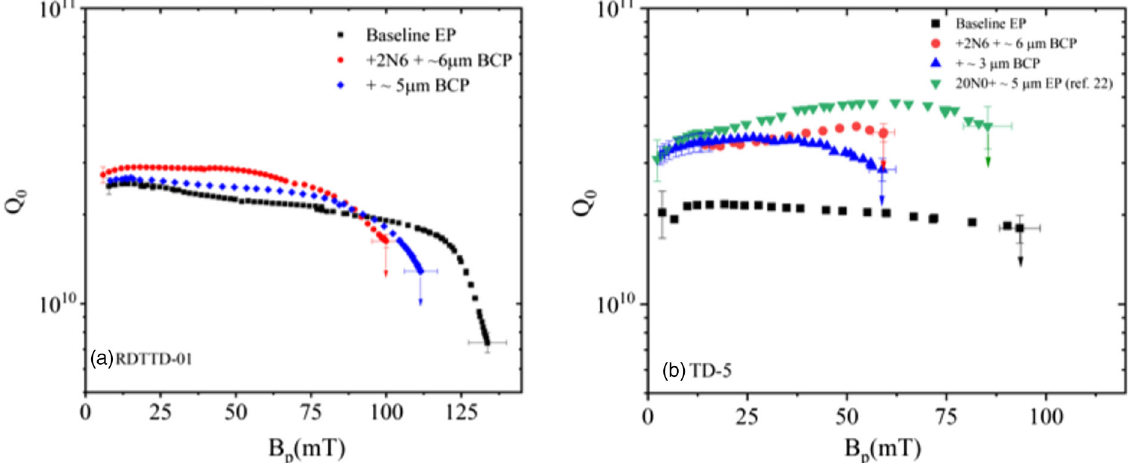
FIG. 9. Q 0 ð B p Þ for (a) RDTTD-01 and (b)TD-5 after nitrogen doping followed BCP. For reference the data also are shown for TD-05 after EP from Ref. [22]. The arrows indicate the limitation by